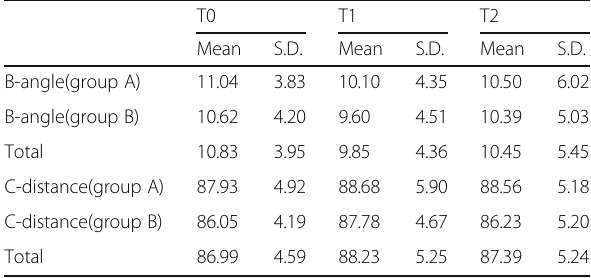
Table 5 Average position of the condyle on the coronal